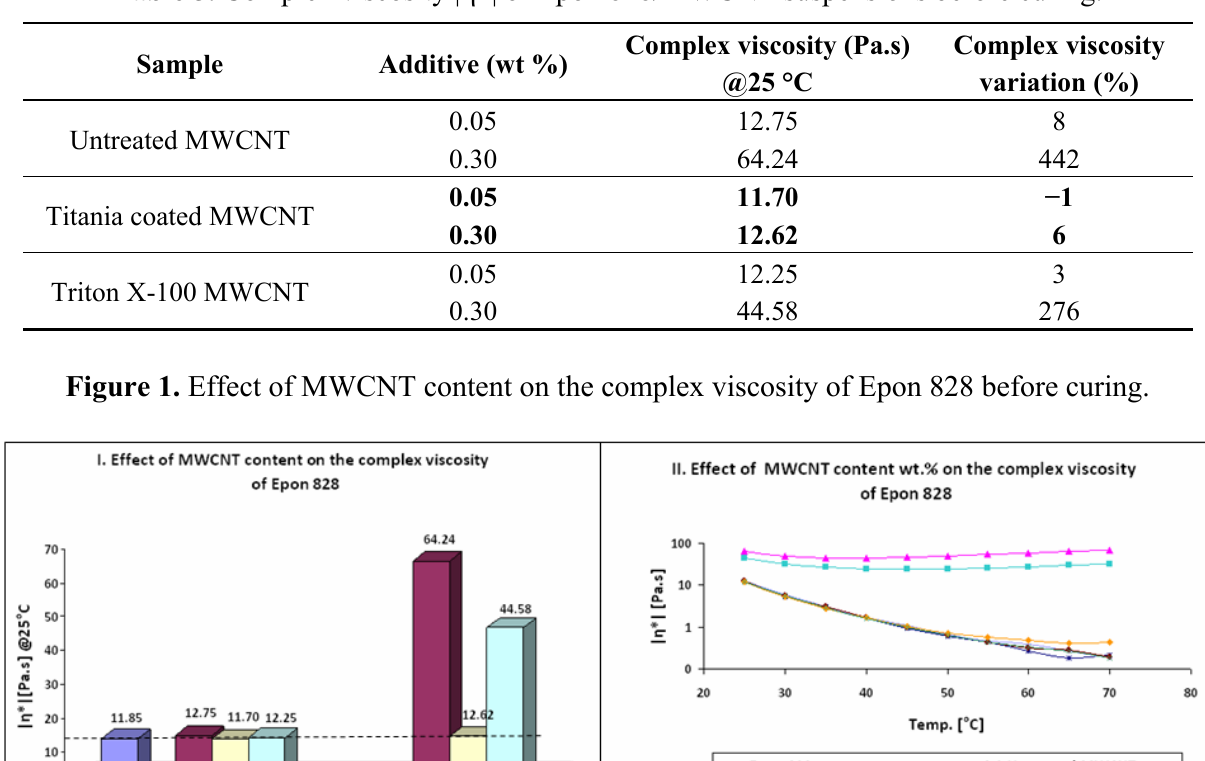
Table 5. Complex viscosity | η *| of Epon 828/MWCNT suspensions before curing.